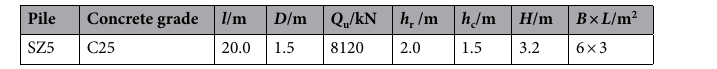
Table 5. Parameter of SZ5.